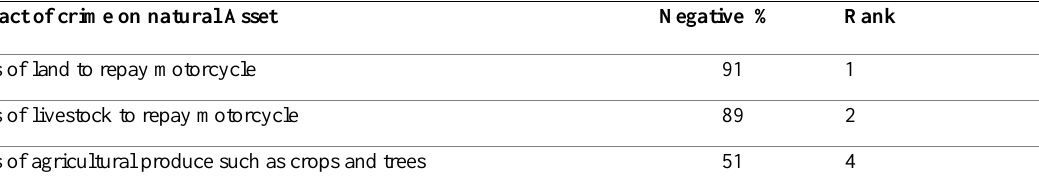
Table 1: Impact of crime on natural Asset